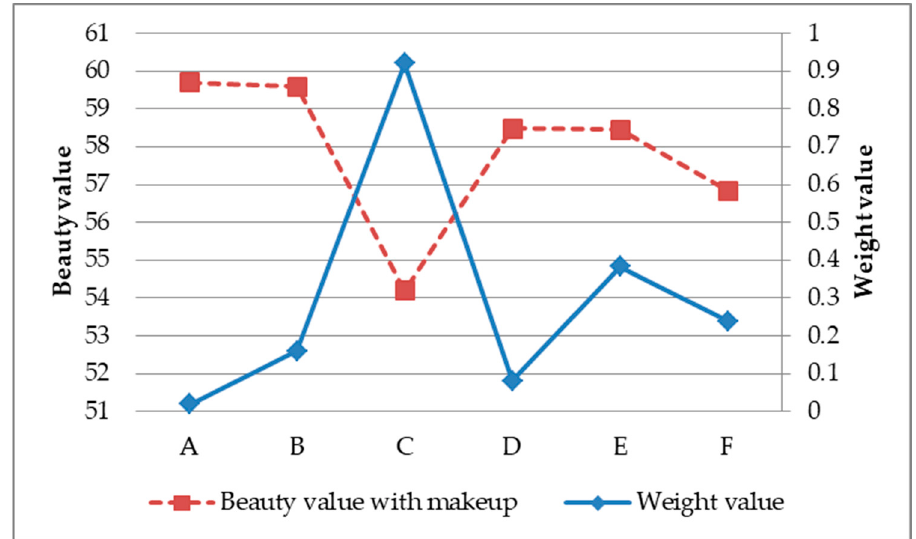
Figure 6. The same girl wears different makeups.